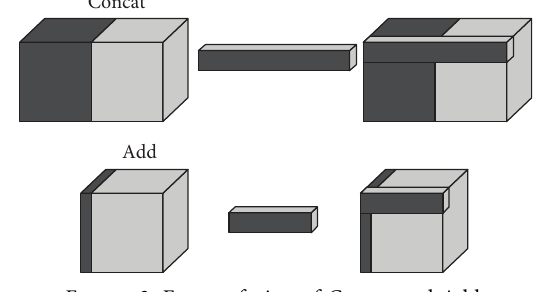
Figure 2: Feature fusion of Concat and